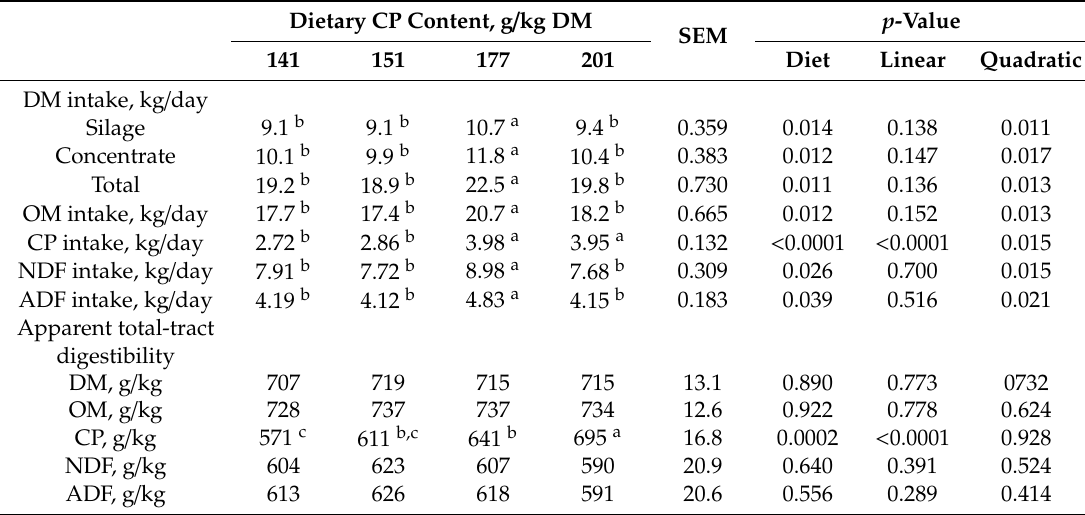
Table 3. E ff ect of dietary CP level on intake and apparent total-tract